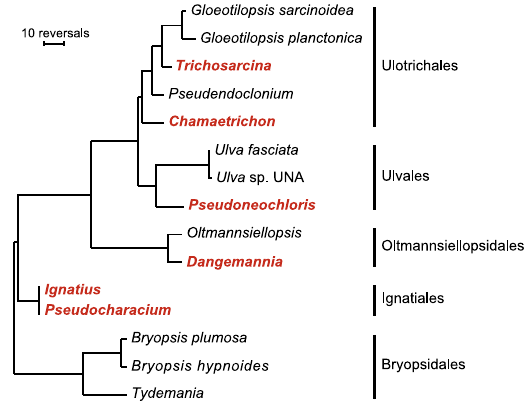
Figure 4. Rearrangements of gene order among ulvophycean chloroplast genomes. The numbers of gene reversals were estimated using MGR v2.03 and the tree topology shown in Fig. 2b. The gene order data set contained 98 genes and included three conserved genes carrying frameshift mutations in Bryopsis hypnoides ( rpoB , rpoC1 and ycf20 ). The names of the newly examined taxa are indicated in